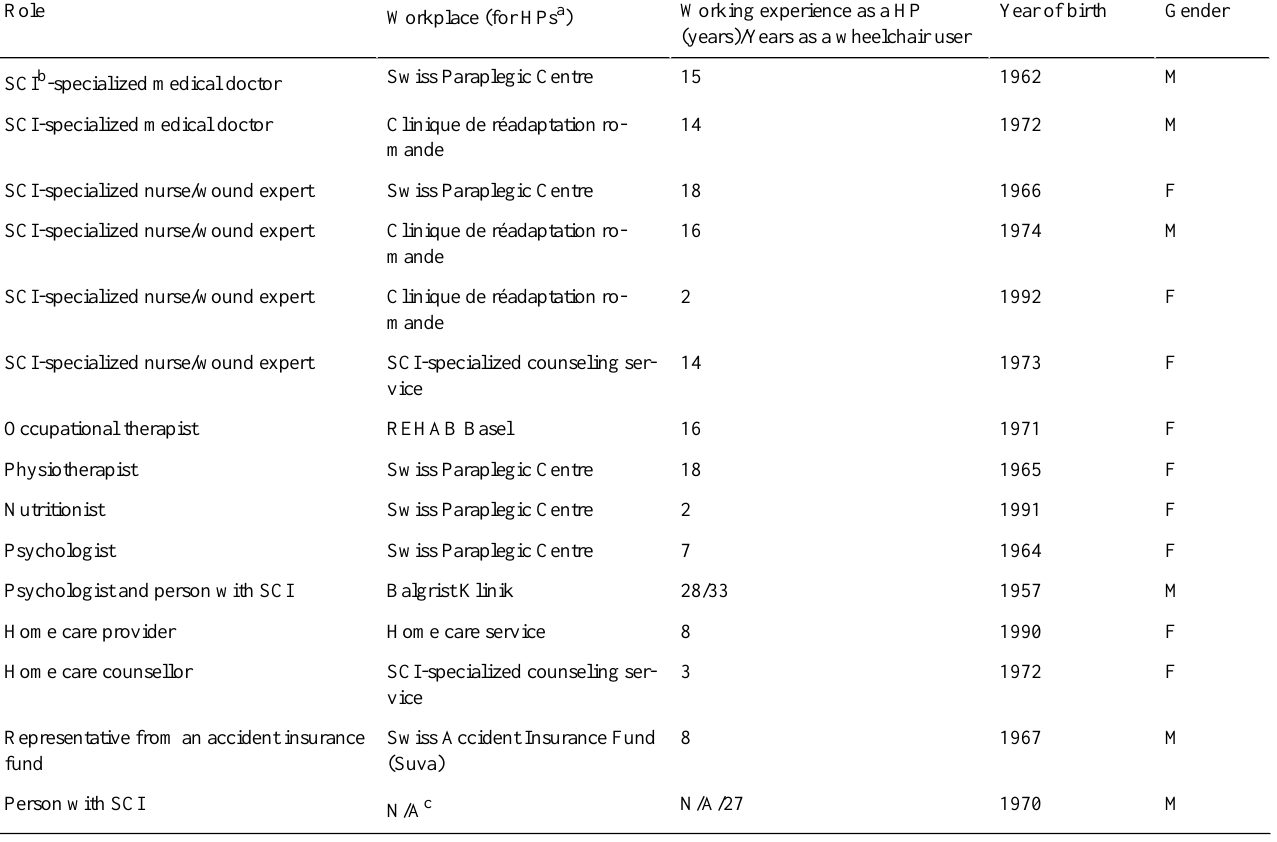
Table 1. Characteristics of participants in the consensus meeting.